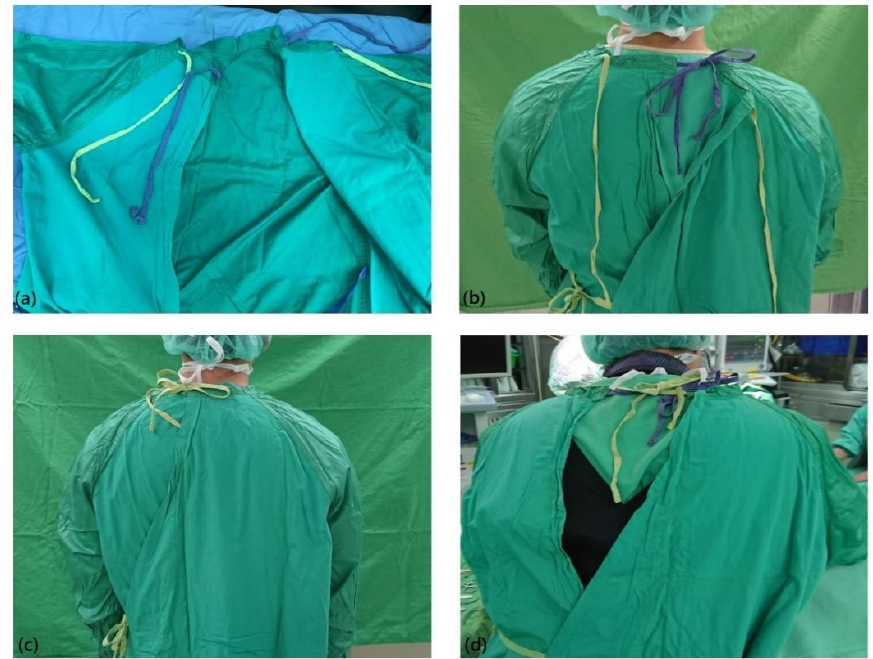
Figure 1. The photographs illustrate ( a ) the design of two sets of rear neck ties, ( b ) the inner tie fastened, ( c ) both ties fastened, ( d ) the ties loosening during surgery.